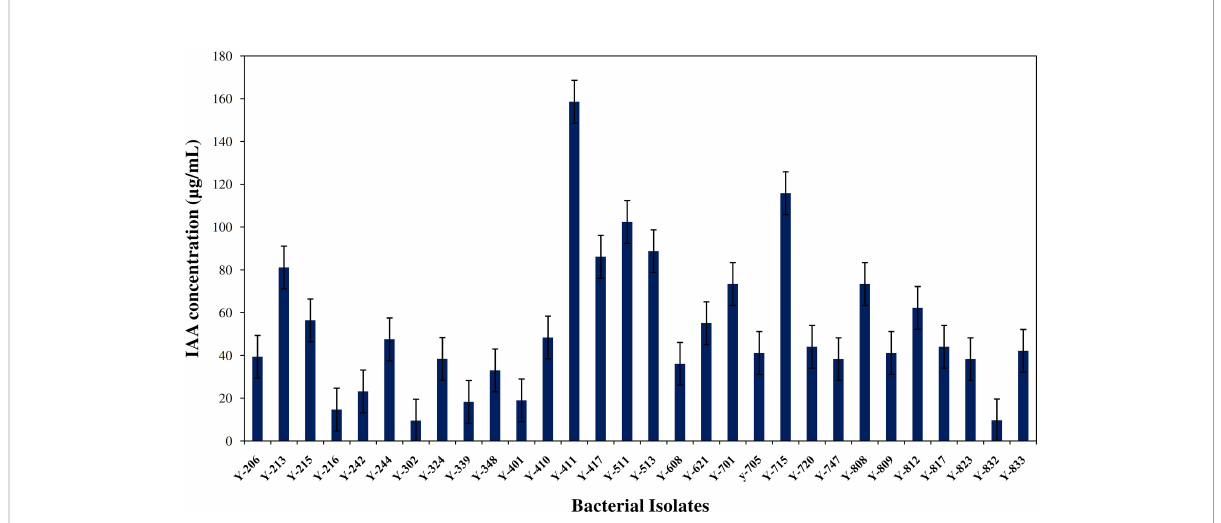
FIGURE 1 Quantitative estimation of bacterial auxin (IAA) produced by isolated strains from orchid roots of R. retusa using tryptophan broth medium